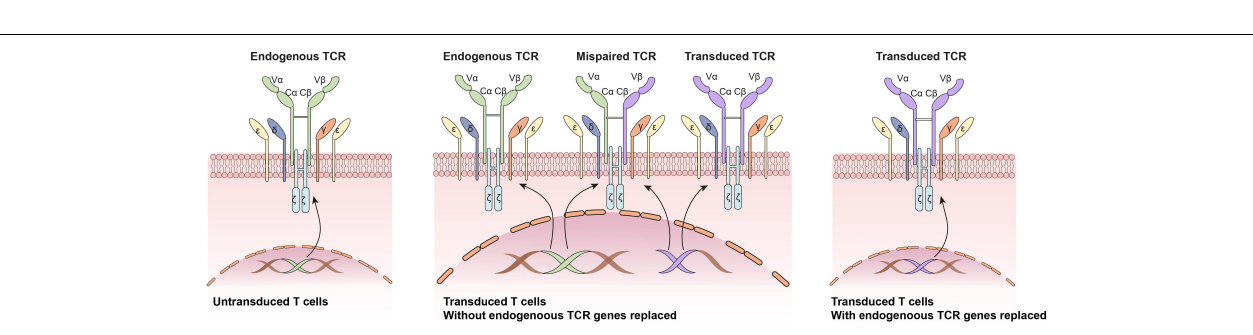
FIGURE 2 | The application of CRISPR/Cas9 system in editing CAR-T cells: Knocking out inhibitory molecules to enhance function of CAR-T cells.